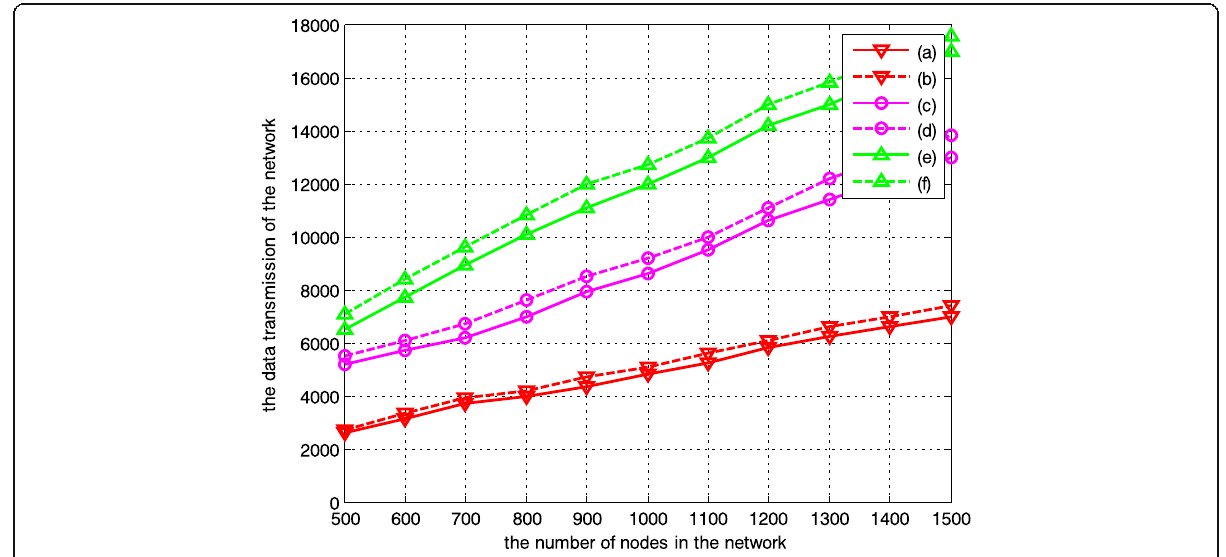
Fig. 4 Comparison of data packet transmission of various programs